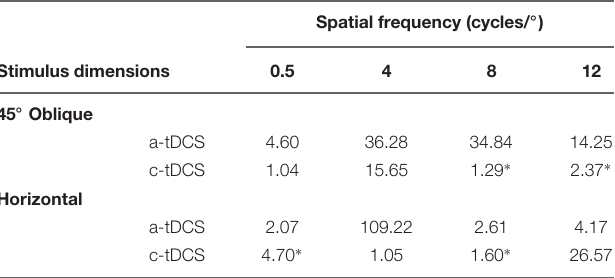
TABLE 2 | Left-Tail Ratios of contrast sensitivity measures in the fixed stimulus size